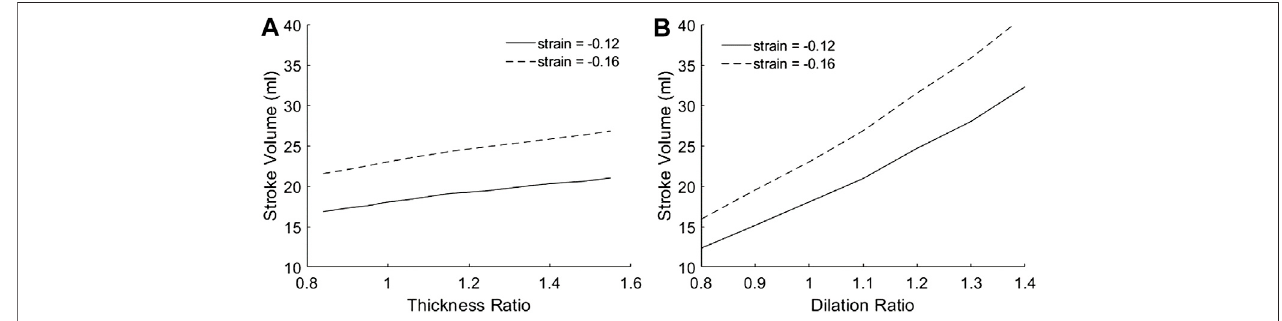
FIGURE 4 | The dependency of SVon (A) myocardial thickness ratio and (B) chamber dilation ratio, when strains at the mid-walllayer were fi xed at either − 0.12 or − 0.16. Results for other myocardial strains are given in Supplementary Figure S2